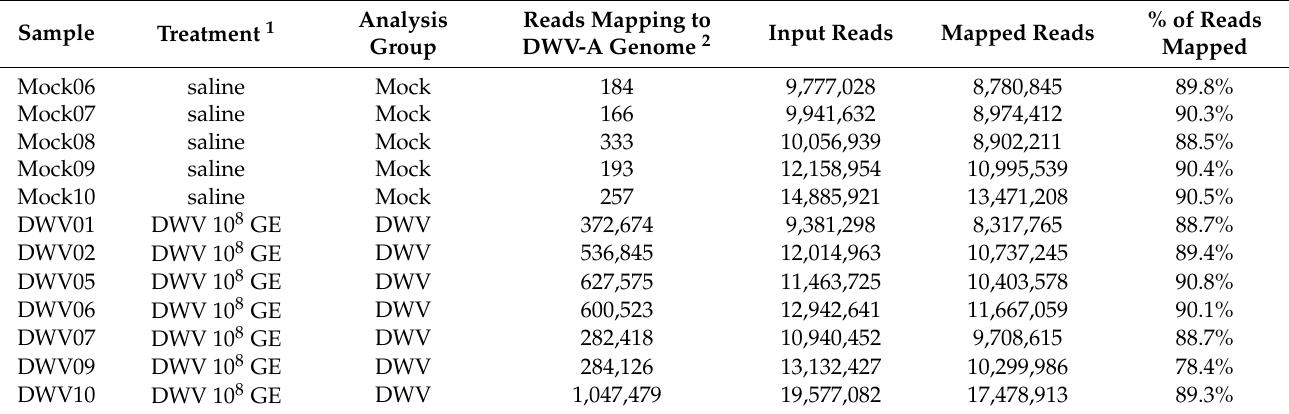
Table 1. Information about the analyzed RNA-Seq